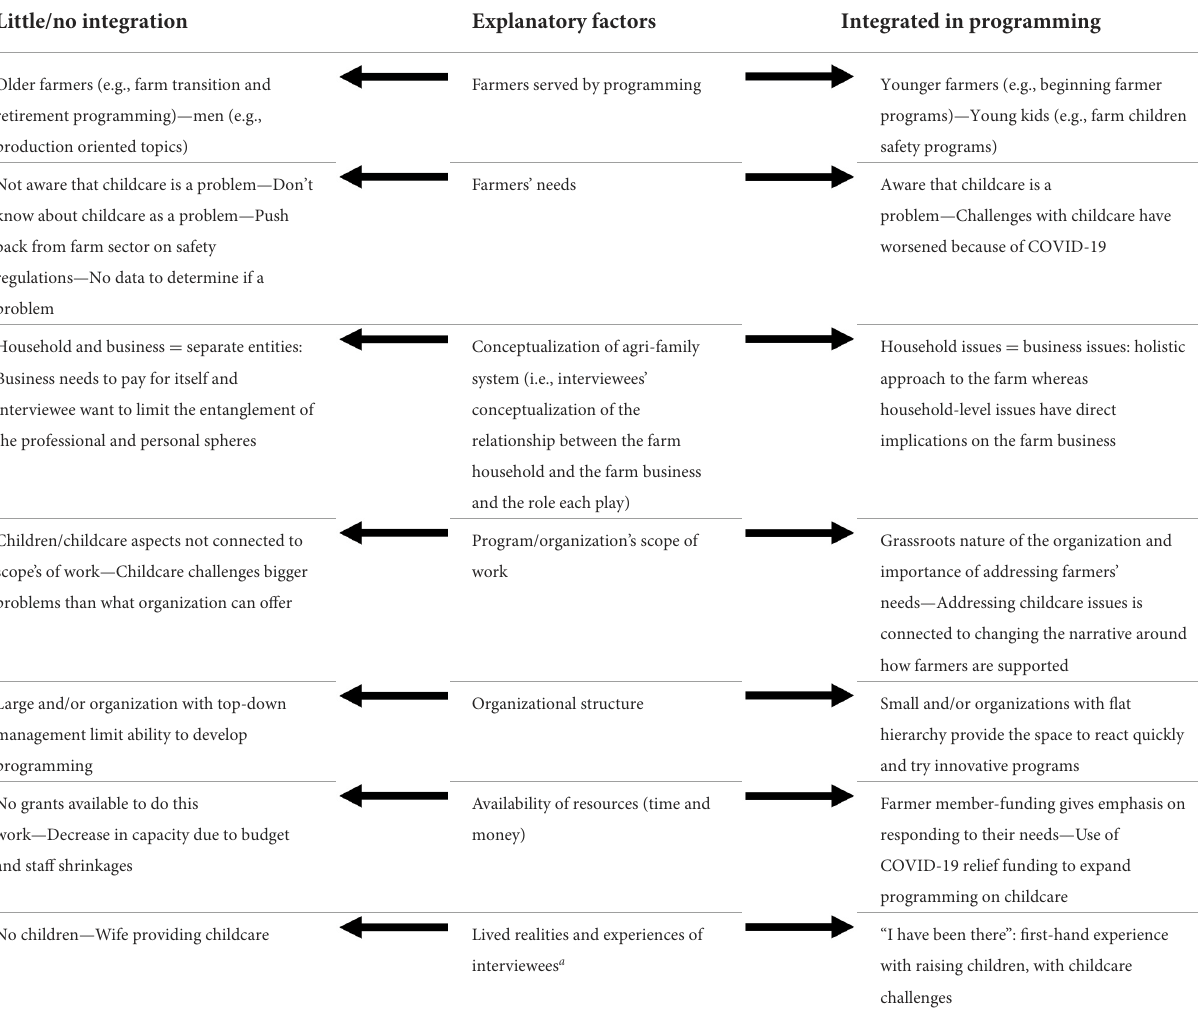
TABLE 3 Factors explaining the level of integration of children and childcare aspects in programming. Little/no integration Older farmers (e.g., farm transition